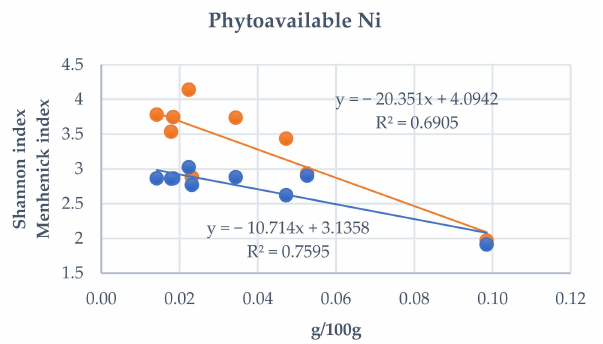
Figure 10. Relationship between the available Ni and Shannon diversity (orange) and Menhinick richness (blue)